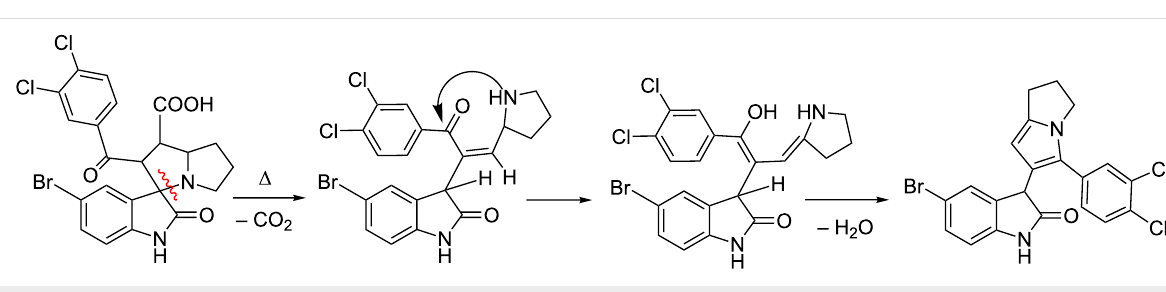
Scheme 3: Tentative reaction mechanism for the decarboxylative cyclative rearrangement of the initial three-component